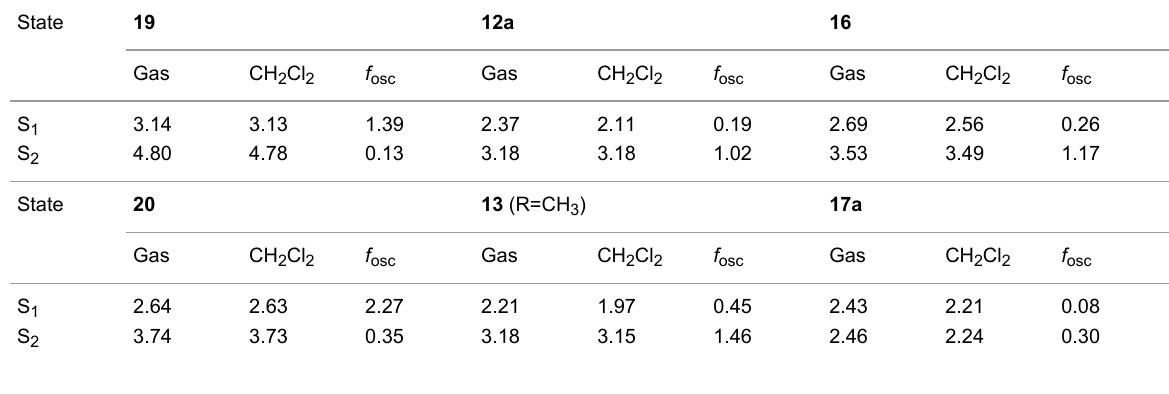
Table 3: Lowest vertical excitation energies obtained by B3LYP/TZVP TD-DFT calculations of the quaterthiophene 19 and derivatives as well as sexithiophene 20 and derivatives (gas phase and in CH 2 Cl 2 ) in eV, and oscillator strengths f osc .